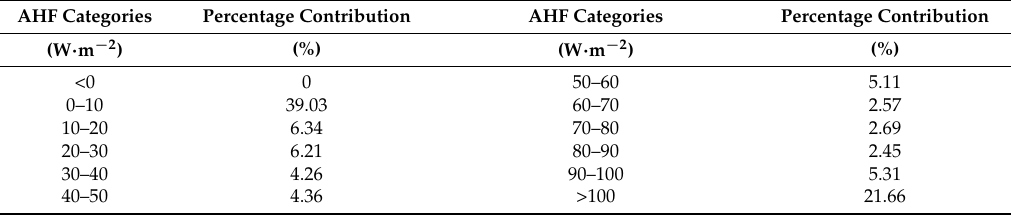
Table 2. The contribution of different AHF categories to the total AHF in the Beijing–Tianjin–Hebei